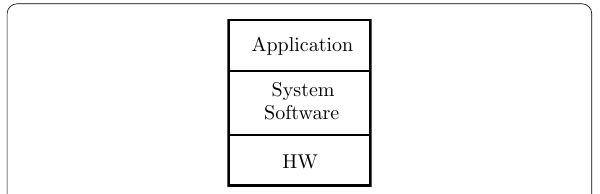
Fig. 2 Embedded systems architecture model according to Noergaard